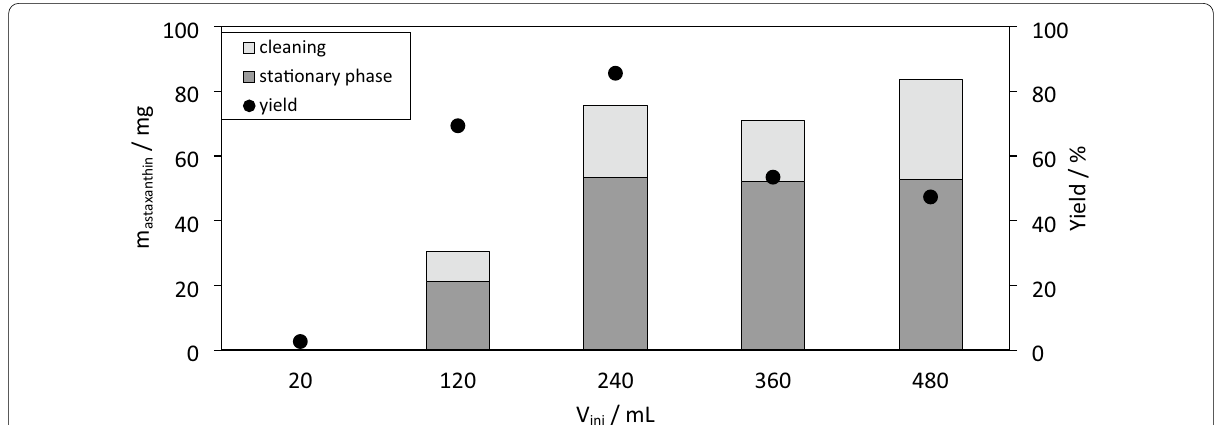
Fig. 3 Astaxanthin extracted into the stationary phase and after cleaning the CPE unit with 80 mL acetone, for injection volumes of 20, 120, 240, 360, and 480 mL of homogenised cyst cells with biomass concentrations of 33 g L − 1 , and a flow rate of 40 mL min − 1 at a rotational speed of 1800 rpm